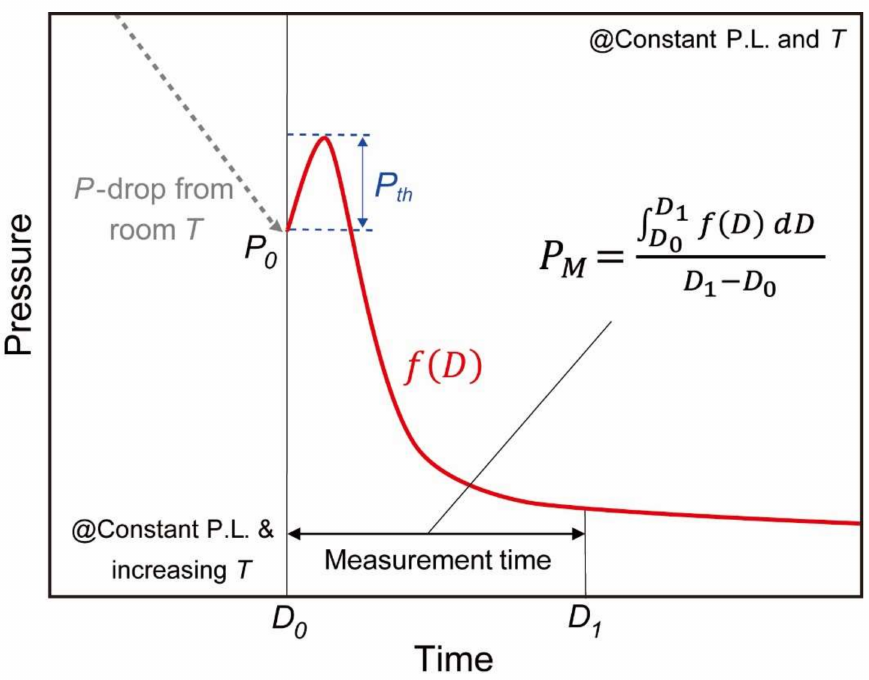
Figure 2. A schematic drawing of pressure drop during and after heating after cold compression at a fixed press load (P.L.). During heating, sample pressure significantly decreases mainly due to stress relaxation. After reaching the target temperature, an initial pressure ( P 0 ) first rapidly increases in a few seconds due to thermal pressure ( P th ) and decreases later, and then slowly decreases. Sample pressure ( P M ) between D 0 and D 1 is an average pressure during the